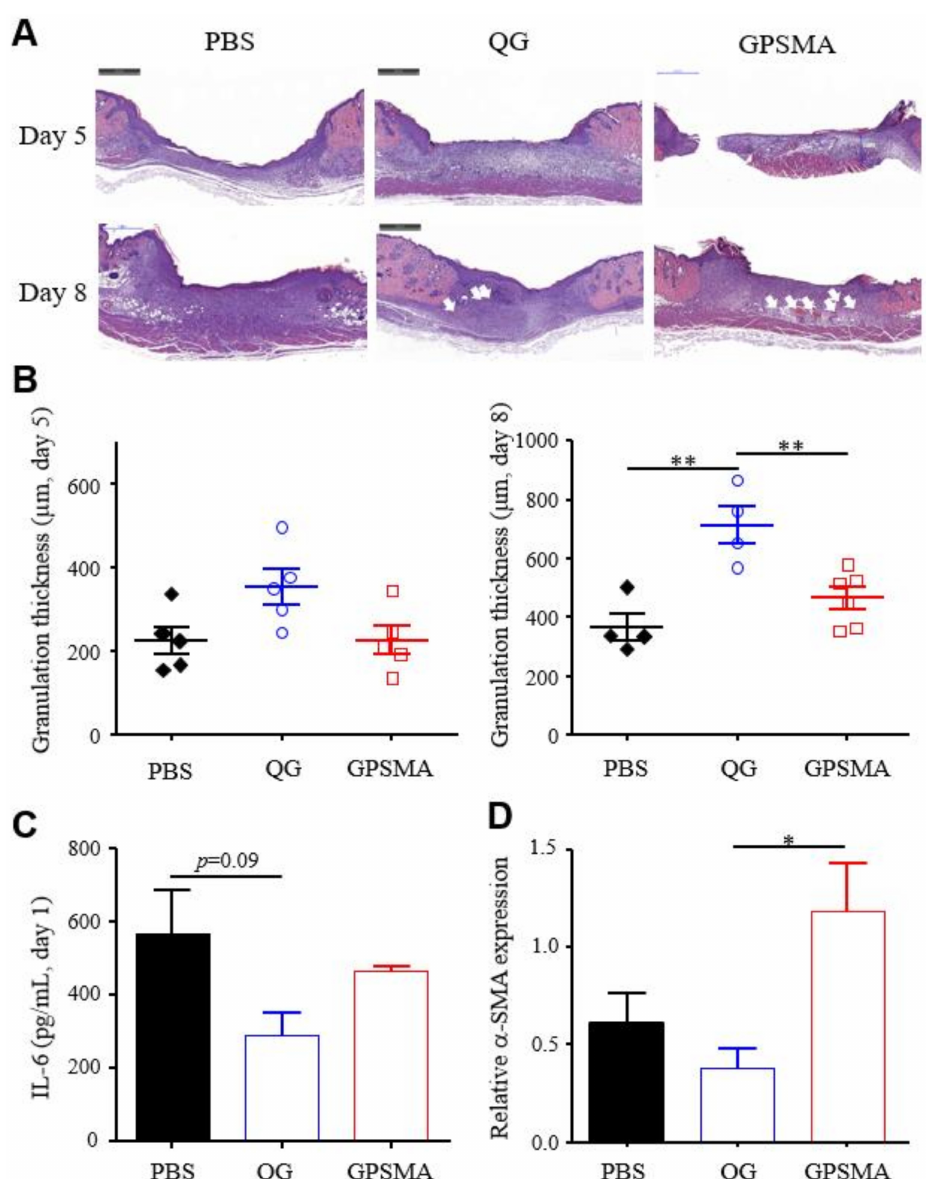
Figure 7. QG improved granulation growth and decreased the inflammation in wound beds. ( A ) A histological section stained with H&E (the scale bar is 500 µ m) and ( B ) quantitative analysis results of granulation thickness. ( C ) The IL-6 levels as analyzed by ELISA and ( D ) the α -SMA levels as analyzed by Western blot analysis. The white arrows indicate blood vessels. Data are reported as the mean ± SD; * indicates a significant di ff erence between samples (* p < 0.05; ** p < 0.01) using a one-way ANOVA with Tukey’s multiple comparisons